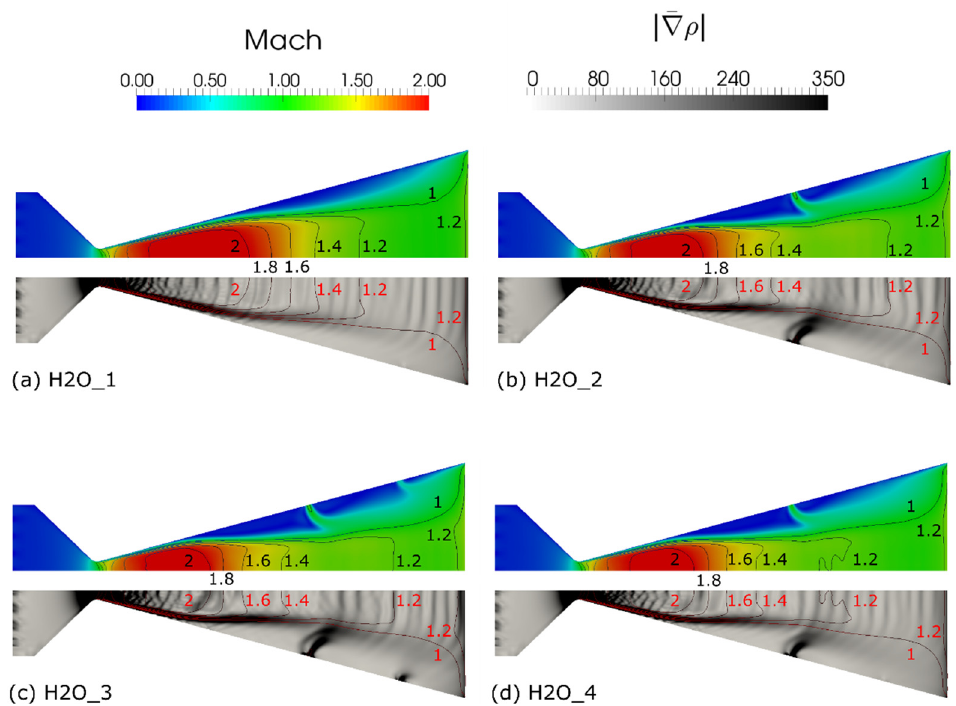
Figure 6. Contour plot of the Mach number and Schlieren computations: ( a ) test case H2O_1 (baseline); ( b ) test case H2O_2 (additional mass flow rate with jet 1 = ON, jet 2 = OFF); ( c ) test case H2O_3 (additional mass flow rate with jet 1 = ON, jet 2 = ON); ( d ) test case H2O_4 (bypassed mass flow rate with jet 1 = ON, jet 2 = OFF).